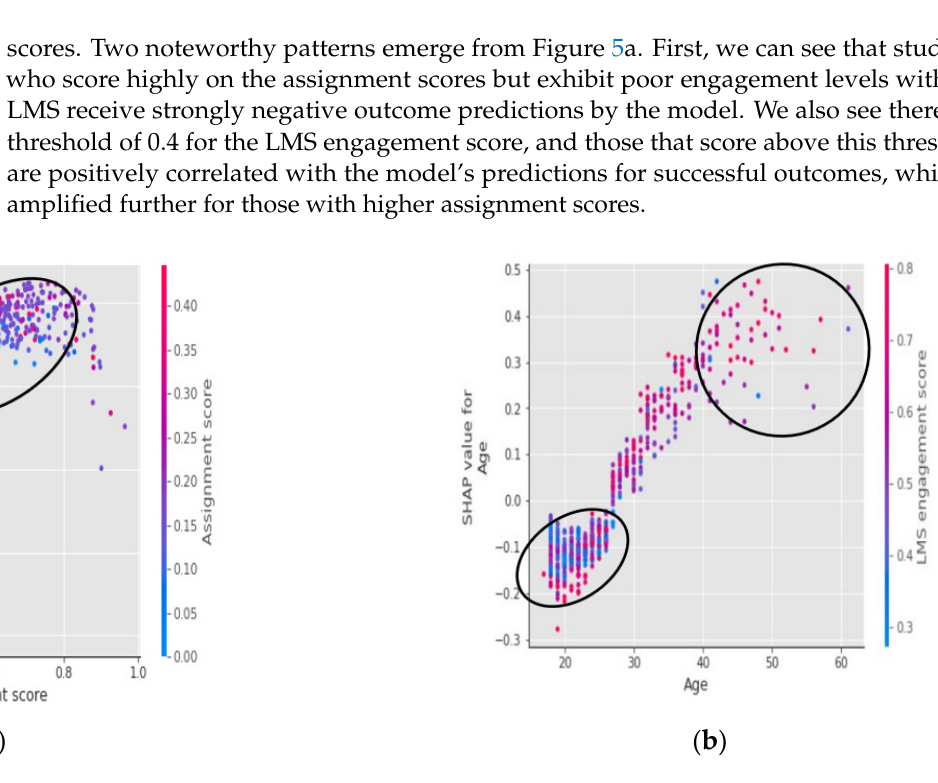
Figure 5. Two SHAP scatter dependence plots: ( a ) left graph depicting the interaction between LMS engagement scores and assignment scores, ( b ) right graph depicting the interaction between learner age and LMS engagement scores. Figure 5b considers the feature interaction of learner age and LMS engagement